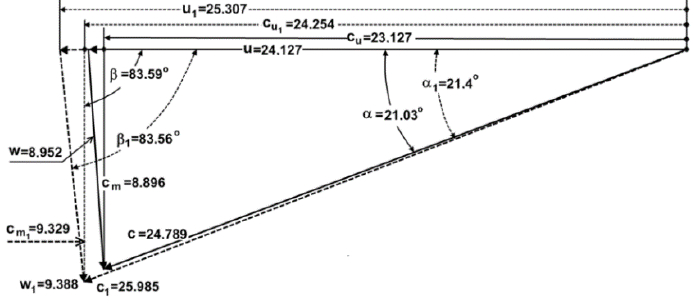
Figure 10. Resulting velocity triangle.